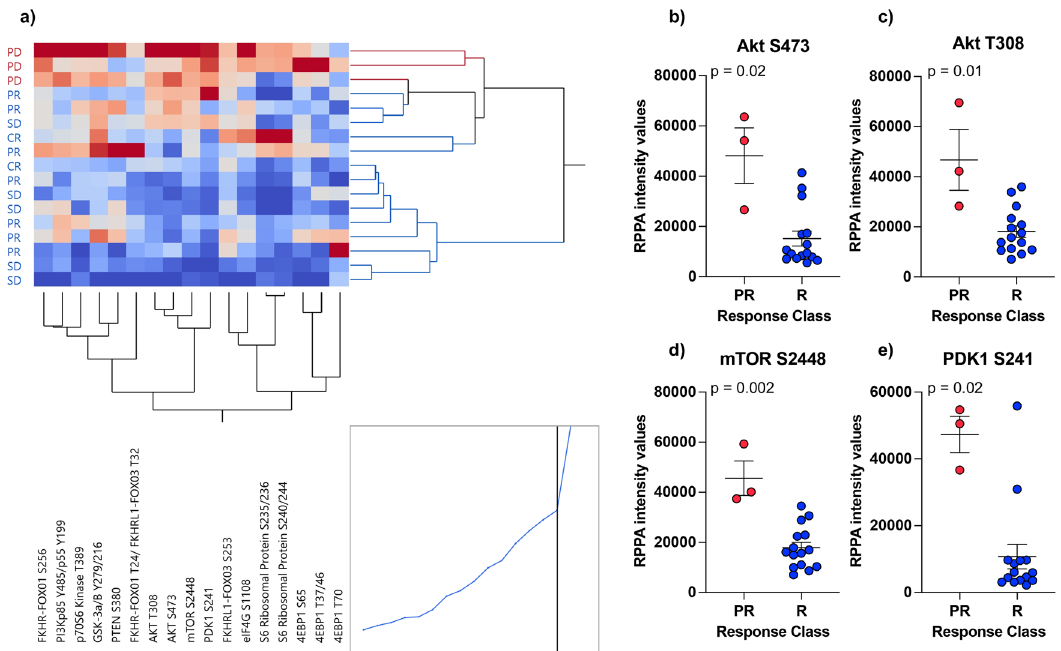
Fig. 6 Activation of the PI3K/AKT/mTOR signaling pathway in the stroma surrounding the tumor of patients with progressive disease compared to responders. Unsupervised hierarchical clustering analysis using Ward ’ s method shows an overall increase in PI3K/AKT/mTOR signaling activity in the stroma of patients that developed progressive disease ( a ). Scatter plots with mean and standard error of the mean showing activation levels of key members of the signaling pathway ( b – e